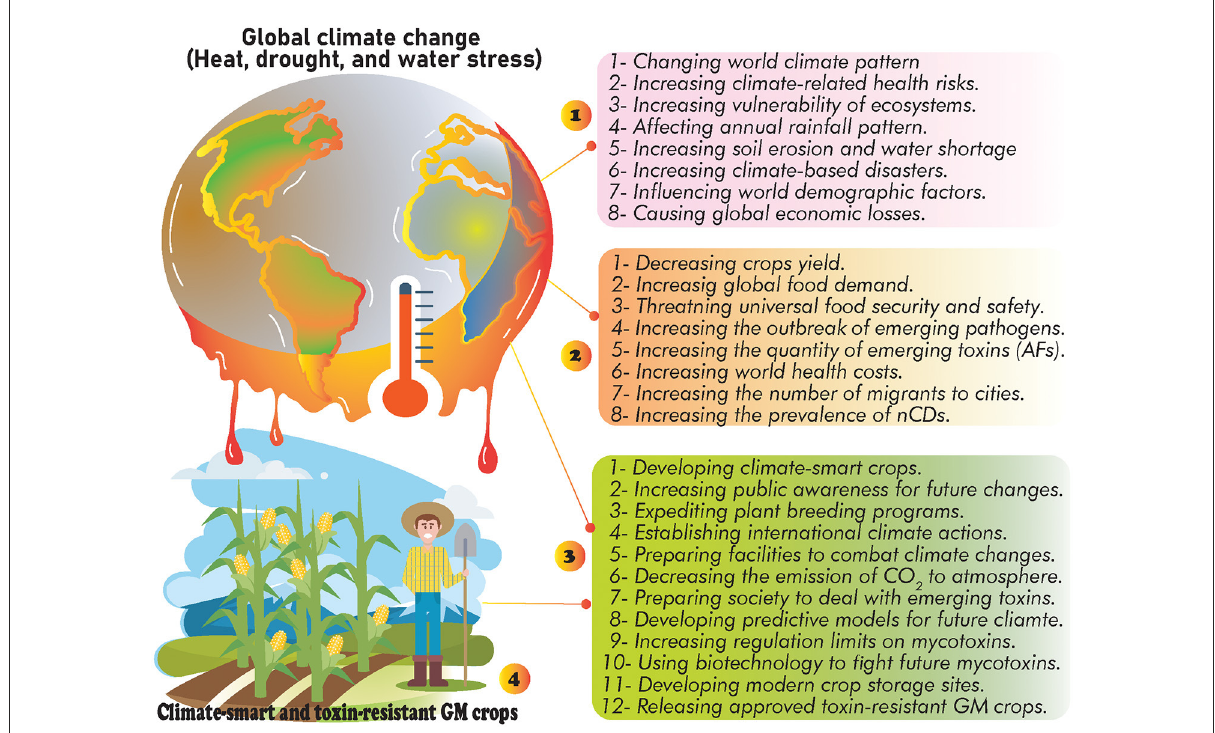
FIGURE2 The possible effects of GCC: (1) general side effects of GCC, (2) consequences of GCC on food security and public health, (3) the suggested strategies to deal with future GCC, and (4) developing climate-smart crops as alternative way to decrease the occurrence of AFs and neutralize the consequences of future